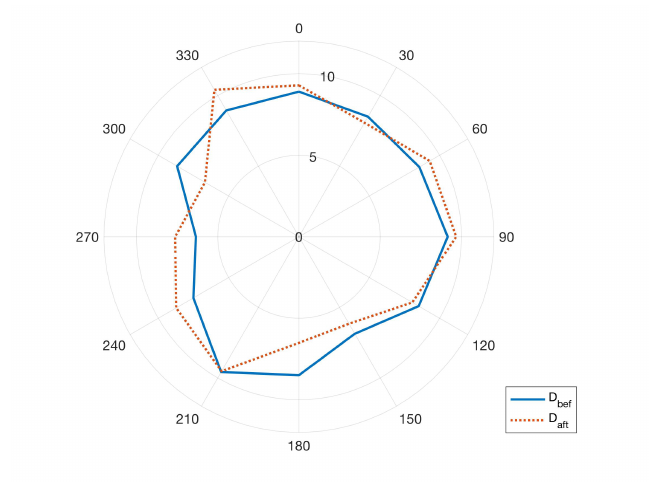
Figure 7. The wind direction rose for Wind Farm 1 during D bef and D aft